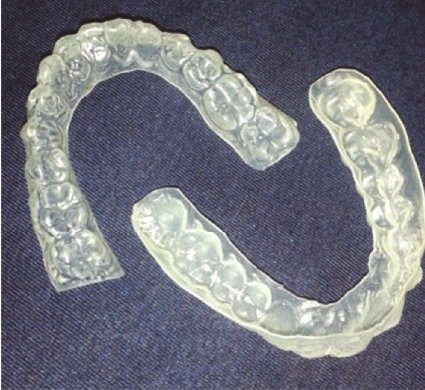
Figure 2: Tray for artificial